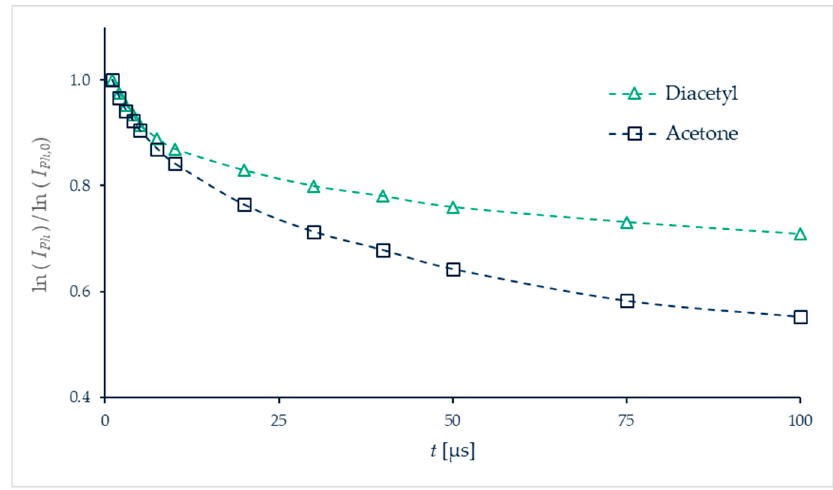
I of phosphorescence emission vs time t for vapor acetone ( □ ) ex- Figure 31. Absolute intensity Figure 31. Absolute intensity I ph of phosphorescence emission vs time t for vapor acetone ( (cid:3) ) excited ph at wavelength λ = 310 nm, and vapor diacetyl ( ∆ ) excited at wavelength λ = 410 nm, both at cited at wavelength 310 nm λ= , and vapor diacetyl ( Δ ) excited at wavelength 410 nm λ= , both at p = 5 kPa and T = 293 K, and normalized by the intensity value I ph ,0 at t = 1 µ s. Data from 5 kPa p = and 293 K T = , and normalized by the intensity value I at = s1 μ t . Data from Fra- ,0 ph Fratantonio et al. [172]. tantonio et al. [ 172 ] .